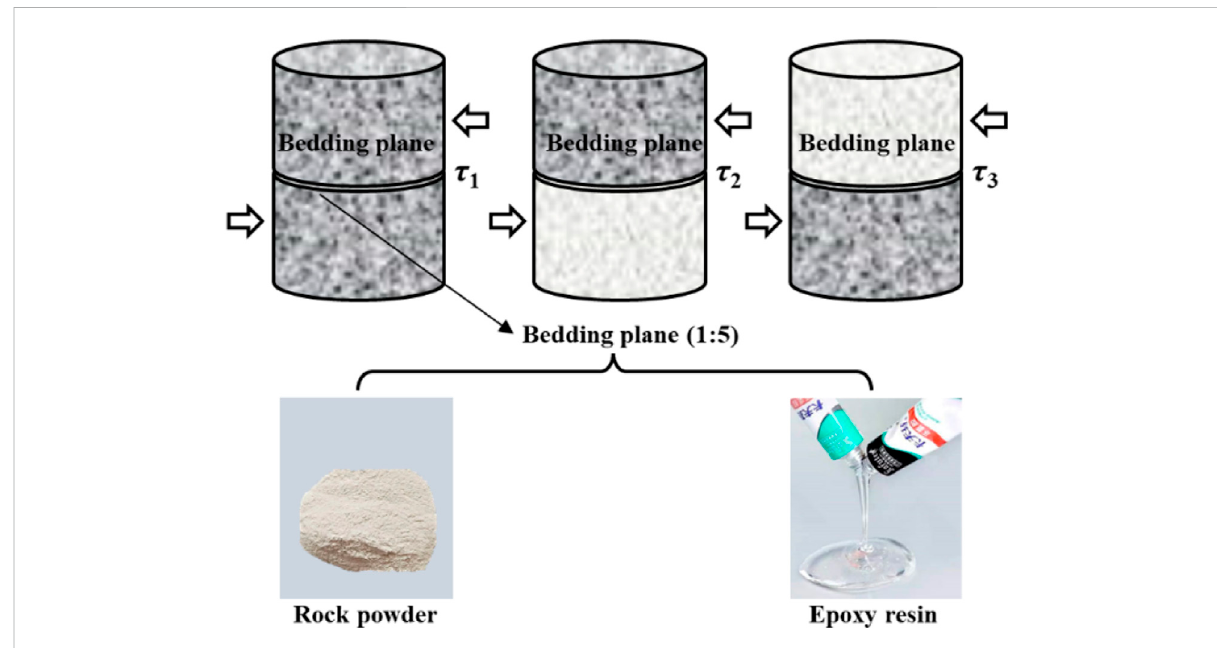
FIGURE 2 The experimental material preparation for sandstone-mudstone combined specimens.